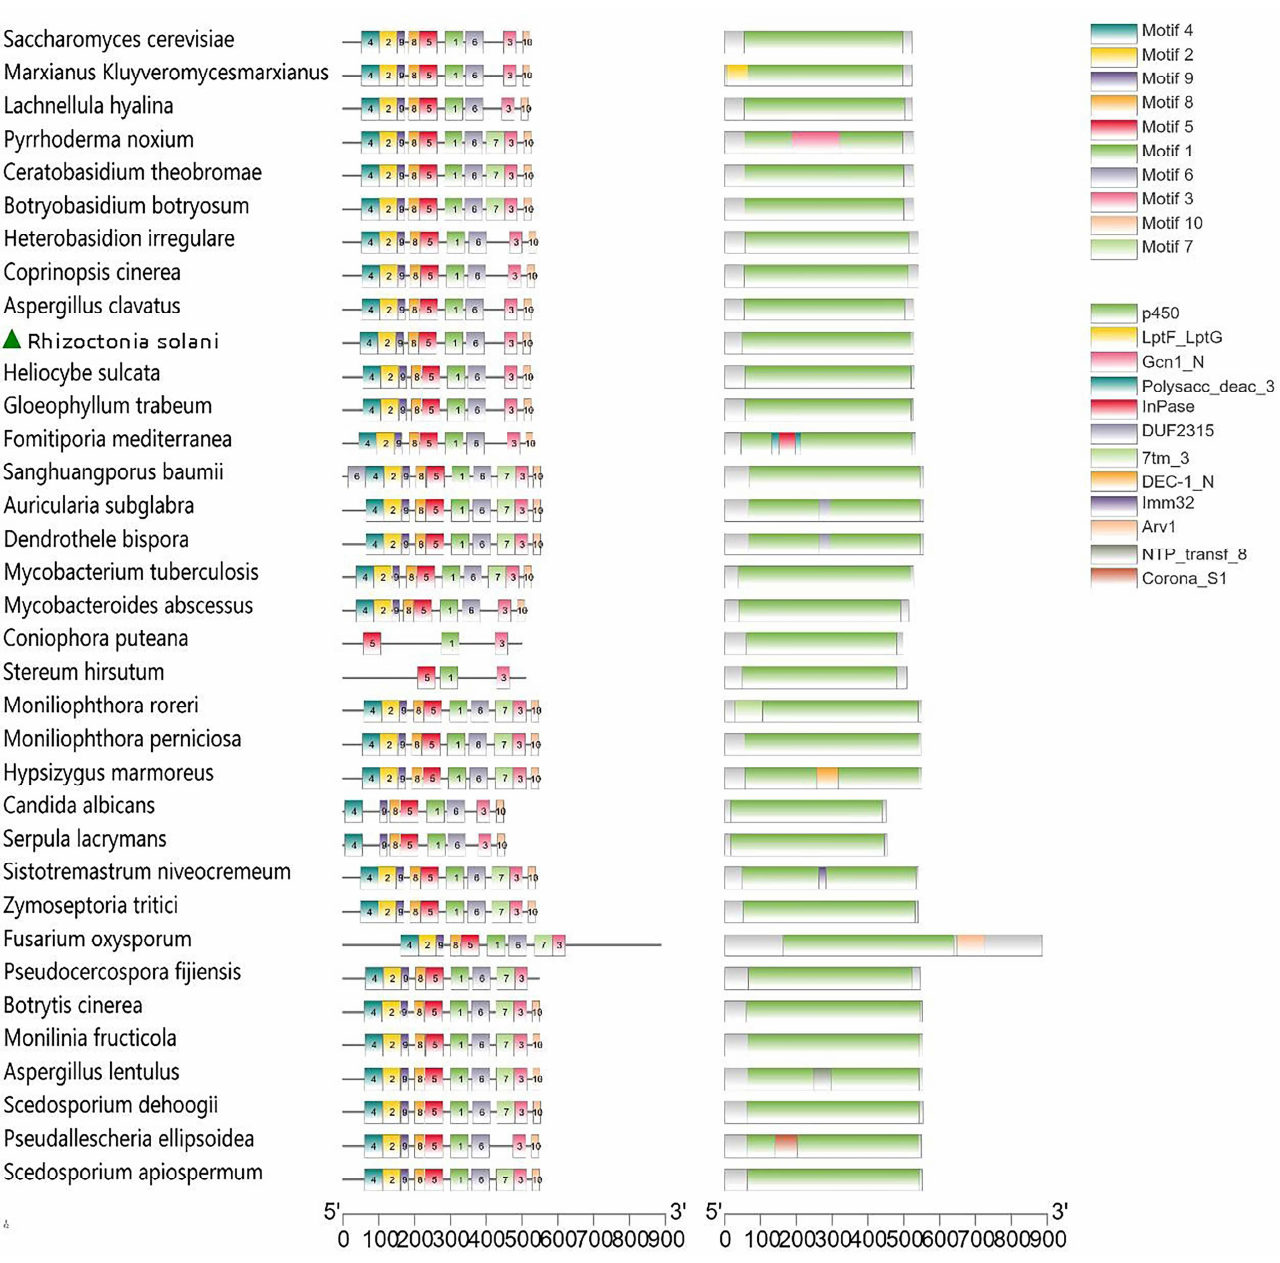
Table 4. Statistics of point mutation information in CYP51 gene.